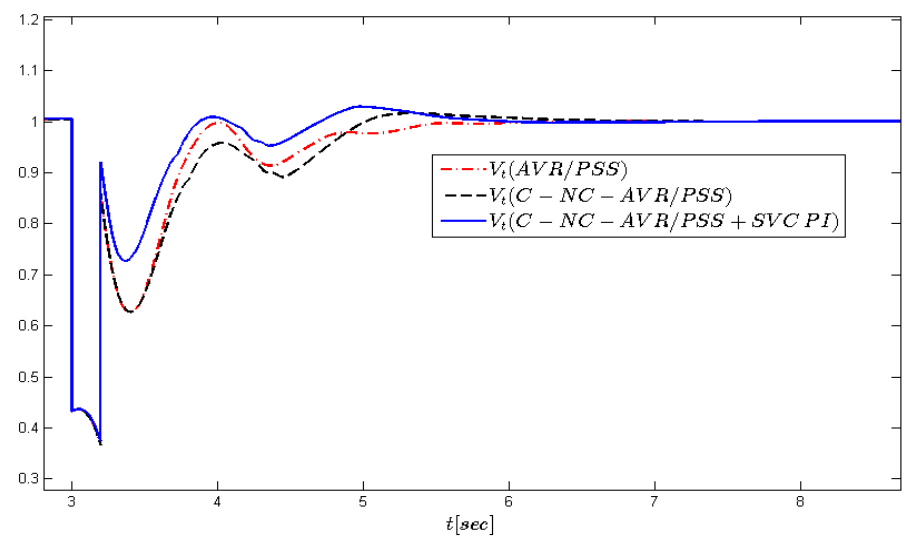
Figure 7. Generator terminal voltage response (in p.u.).